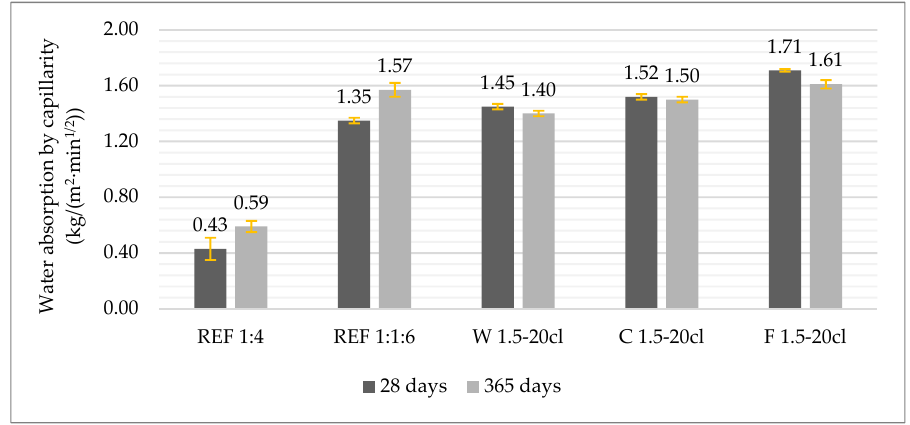
Figure 4. Water absorption by capillarity coefficient.